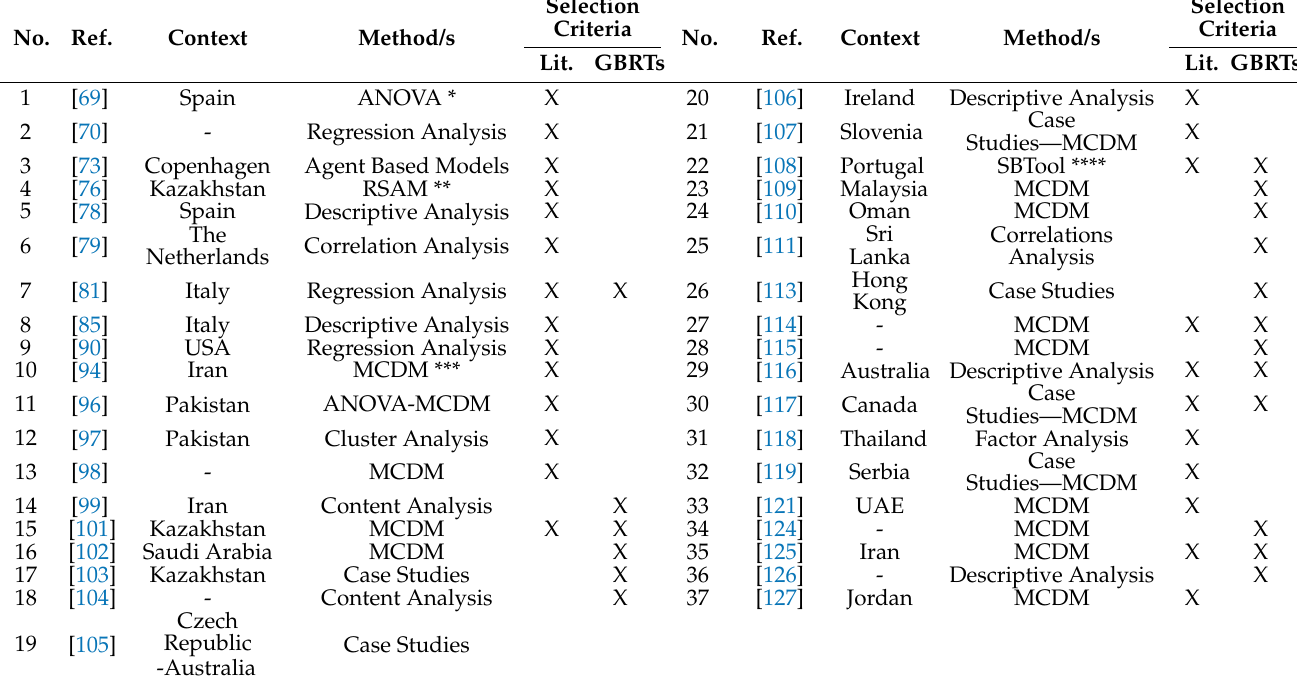
Table 3. A Summary of Perception and Assessment of Sustainability